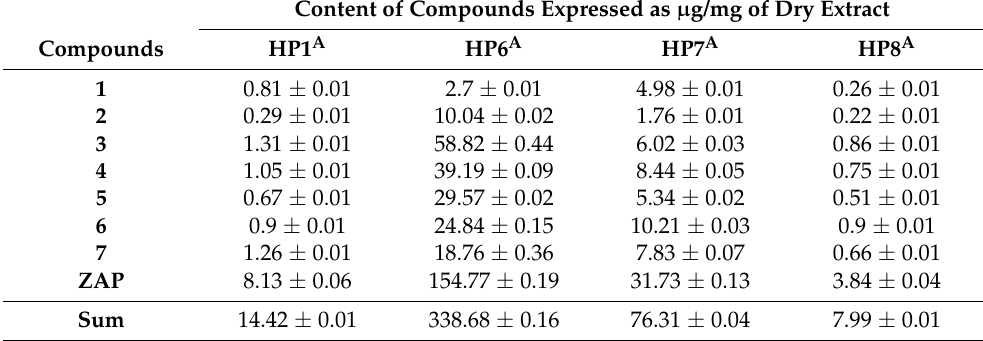
Table 2. Quantification results of the flavonoids in the extracts HP1 and HP6–8 . Content of Compounds Expressed as µ g/mg of Dry Extract